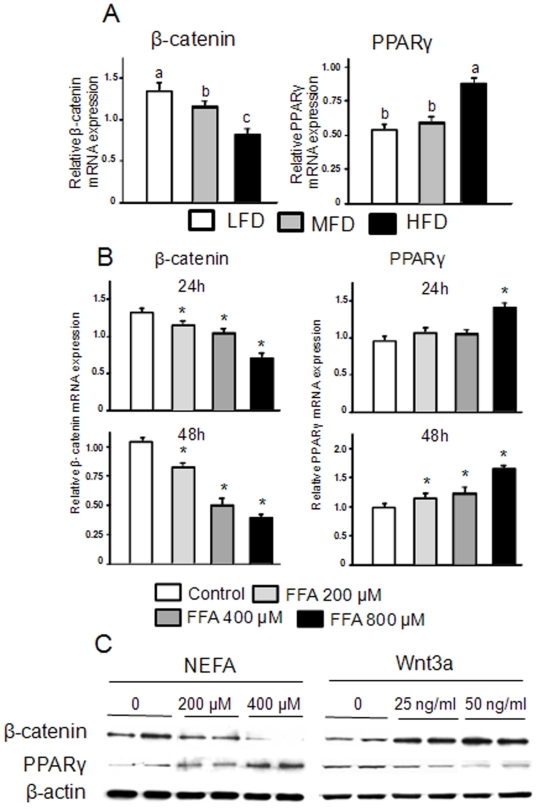
Serum from HFD fed rats and an artificial FA mixture down-regulate β-catenin but up-regulate PPARγ in ST2 cells, Wnt3a does the opposite.(A), ST2 cells were treated with 2% serum from LFD, MFD or HFD rats for 3 days. Cell RNAs were isolated and real-time PCR was performed for β-catenin and PPARγ. (B), ST2 cells were treated with three different concentrations of FAs (200, 400 or 800 µM) for 24 h and 48 h. Cell RNAs were isolated and real-time PCR was performed for β-batenin and PPARγ. (C), ST2 cells were treated with a FA mixture and Wnt3a respectively for 24 h. Cell protein lysates were collected, and western blots were performed for β-catenin, PPARγ and β-actin in duplicates. Data bars are expressed as mean ± SEM (n = 3/treatment). Means with different letters differ significantly from each other at P<0.05, a>b>c, *, P<0.05, versus control as determined by two-way ANOVA followed by Student-Newman-Keuls post hoc analysis for multiple pairwise comparisons.